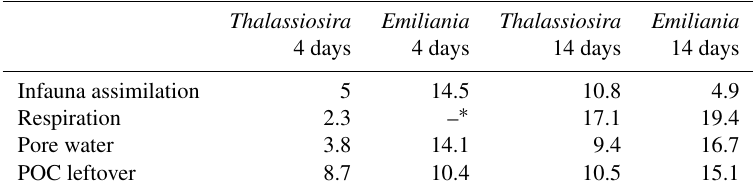
Table 2. Molar C:N ratios for each of the measured